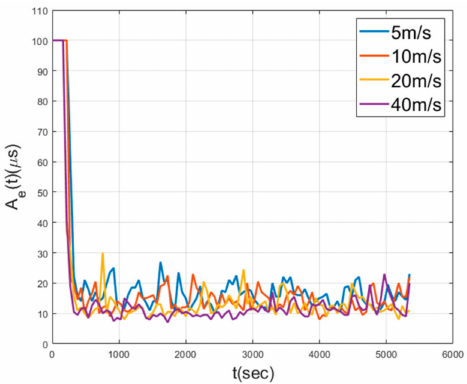
Figure 16. Mobile network error with 2 malfunction nodes.